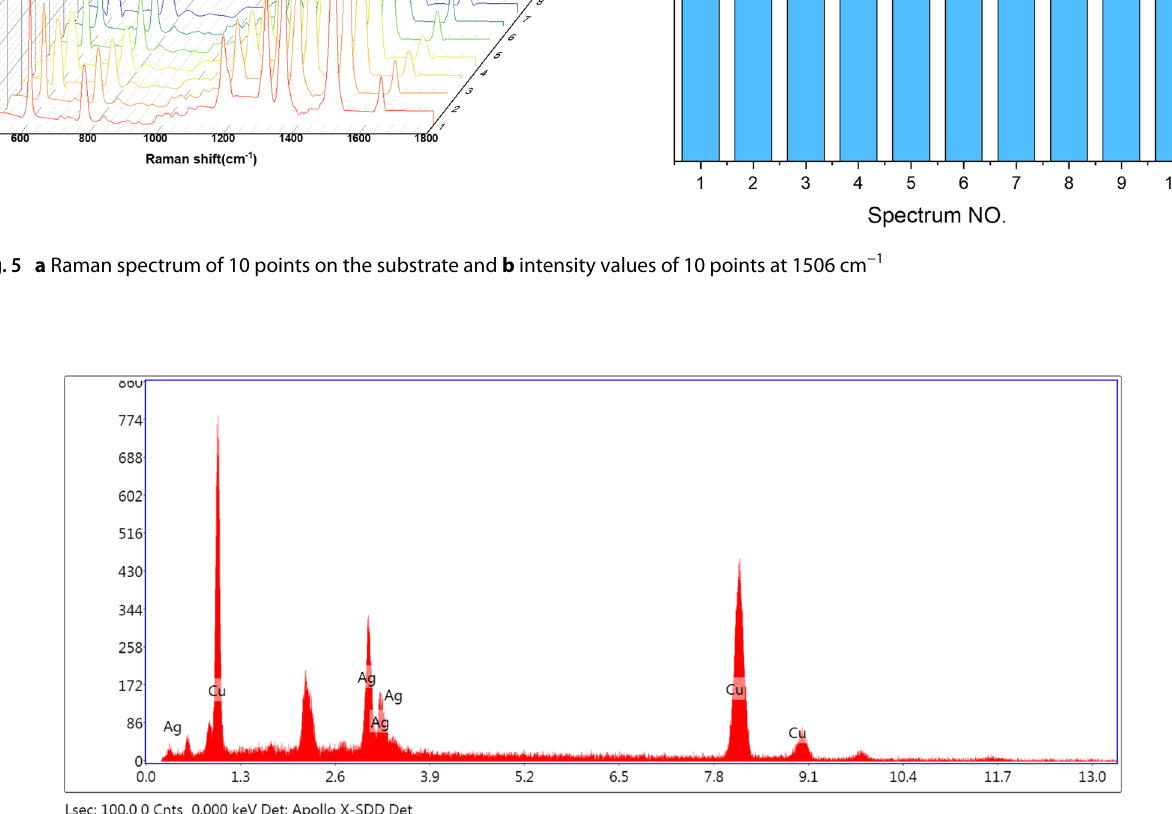
Fig. 6 EDS picture of Cu–Ag